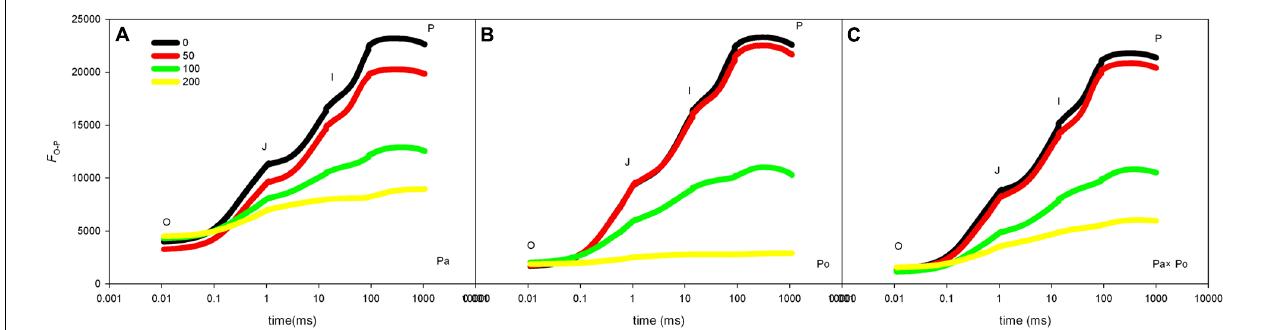
FIGURE 3 | The effect of salt stress on the OJIP curves of leaves of the three P. amurensis . The effect of salt stress on the OJIP curves of P. amurensis (A) , the effect of salt stress on the OJIP curves of P. opulifolius “Diabolo” (B) , and the effect of salt stress on the OJIP curves of hybrid P. amurensis (C) . Note: Pa, P. amurensis Maxim ( ); Po, P. opulifolius “Diabolo” ( ). Data in the figure are mean ± SE; values followed by different lowercase letters indicate a significant difference ( p < 0.05). ♀ ♂ ♂